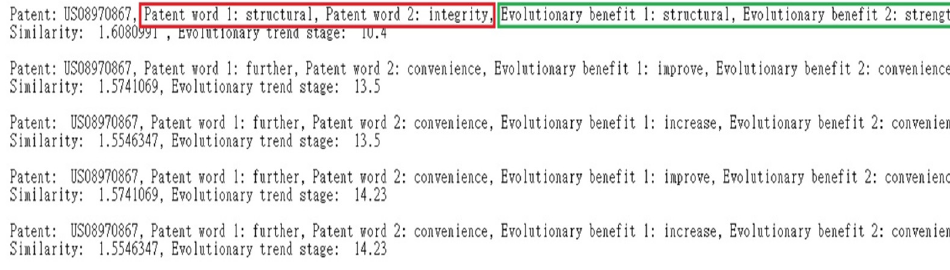
Figure 8. Result of similarity calculation greater than 1.55 (partial).